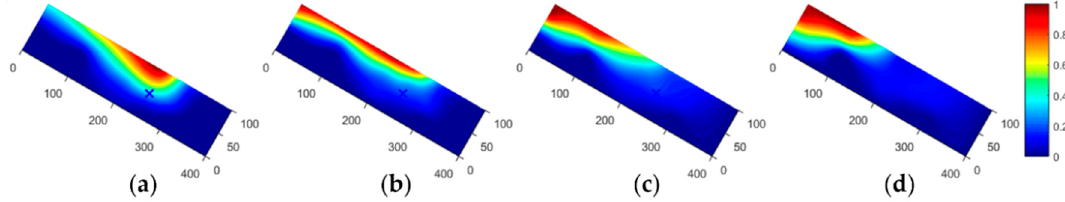
Figure 7. The gas distribution at different shut-in times of Exp2. ( a ) 24 h after shut-in; ( b ) 48 h after shut-in; ( c ) 72 h after shut-in; ( d ) 96 h after shut-in.